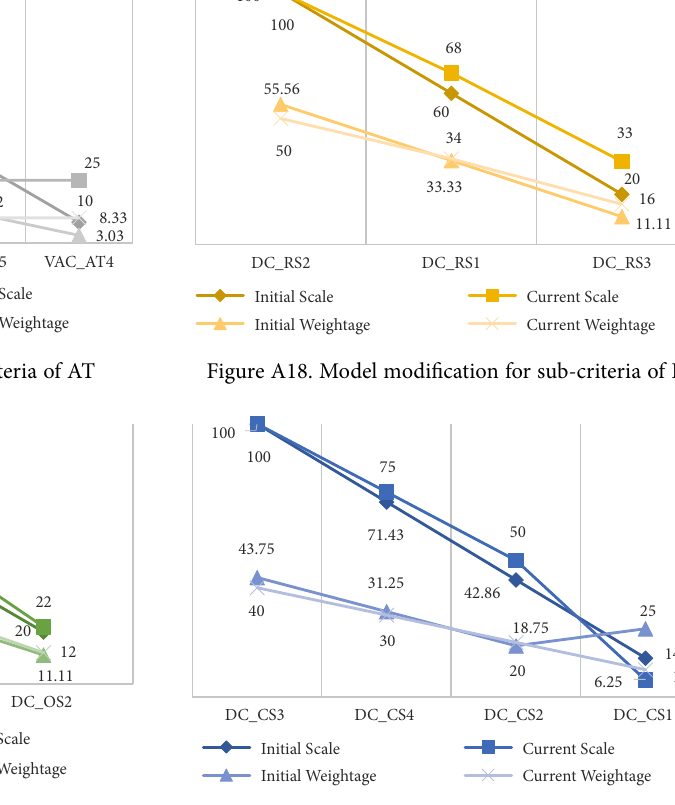
Figure A19. Model modification for sub-criteria of OS Figure A20. Model modification for sub-criteria of CS